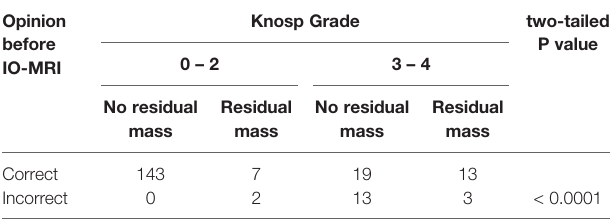
TABLE 3 | Comparison of primary surgeon opinion before intraoperative magnetic resonance imaging and fi ndings after scan. Opinion